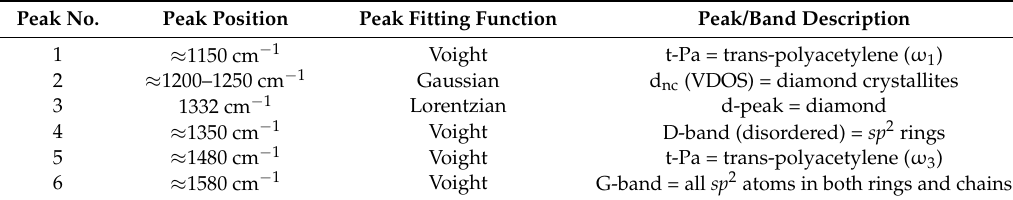
Table 1. The parameters of the deconvolution fitting process. Peak No. Peak Position Peak Fitting